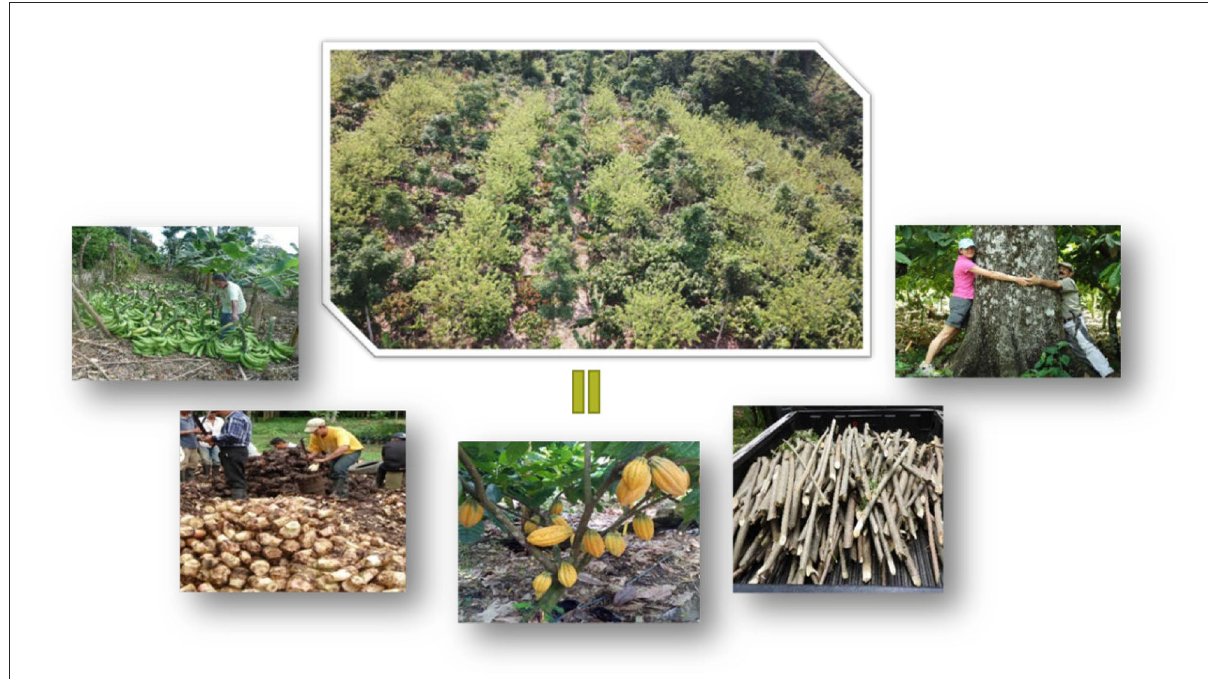
FIGURE2 Harvestable good and products (plantain corms + bundles, madreado steaks, cacao beans and timber lumber) from the 12 timber-based cacao agroforestry systems in the experimental site “CEDEC-JAS”, La Masica, Atlántida, Honduras.